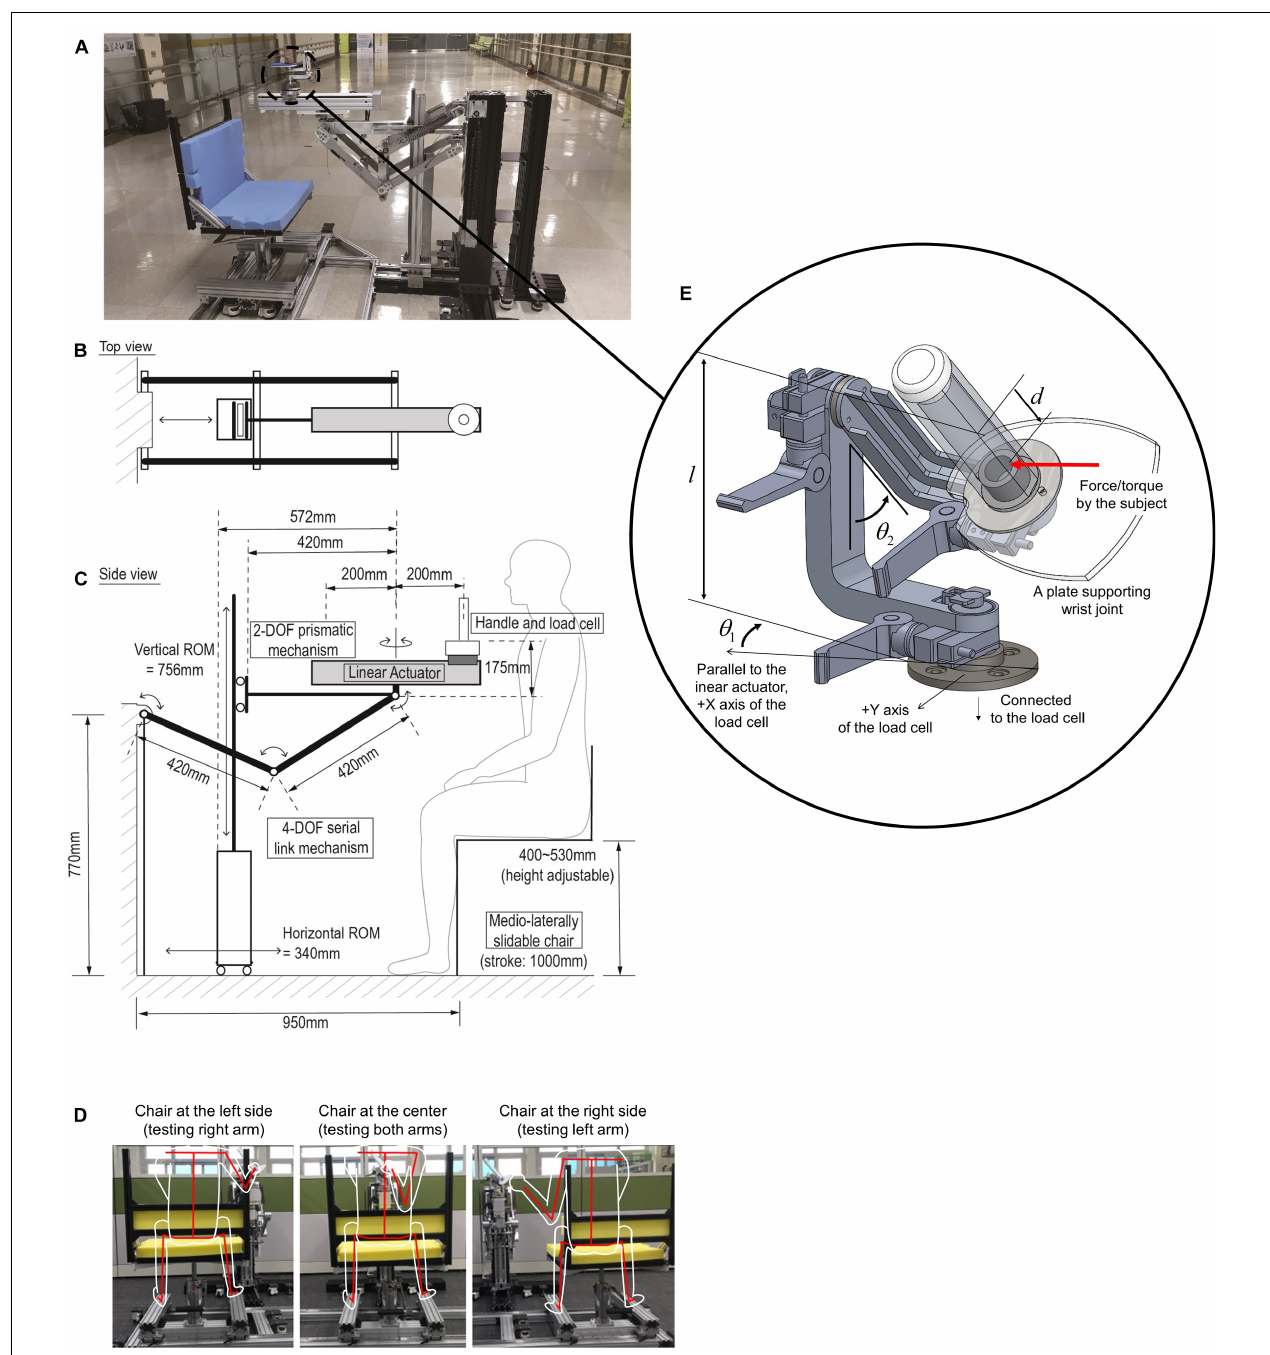
FIGURE 1 | (A) Whole components of KULSIS. (B,C) Schematic of its structure in the top and the side view, respectively. (D) Single DOF sliding chair mechanism to determine medial-lateral position of the linear actuator to the subject (represented by white outlines, and a red skeleton). Depending on the relative position of the chair with respect to the linear actuator, either the right or left arm can be assessed. (E) The three-DOF gimbaled handle mechanism. The handle is mounted on the load cell. l and d represent the distance from the load cell to the rotational center of the gimbal and the distance from the rotational center to the point where the subject applies the force and the moment, respectively. θ 1 and θ 2 represent the angles of the first and the second gimbal joints, respectively.